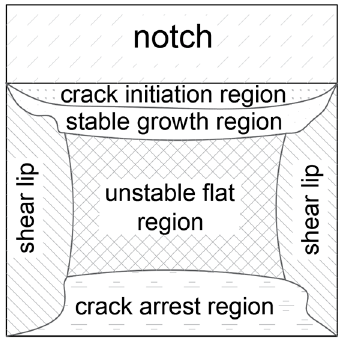
Figure 7. Fracture development stages in an ISO Charpy V sample on the typical fracture surface of mixed ductile character.